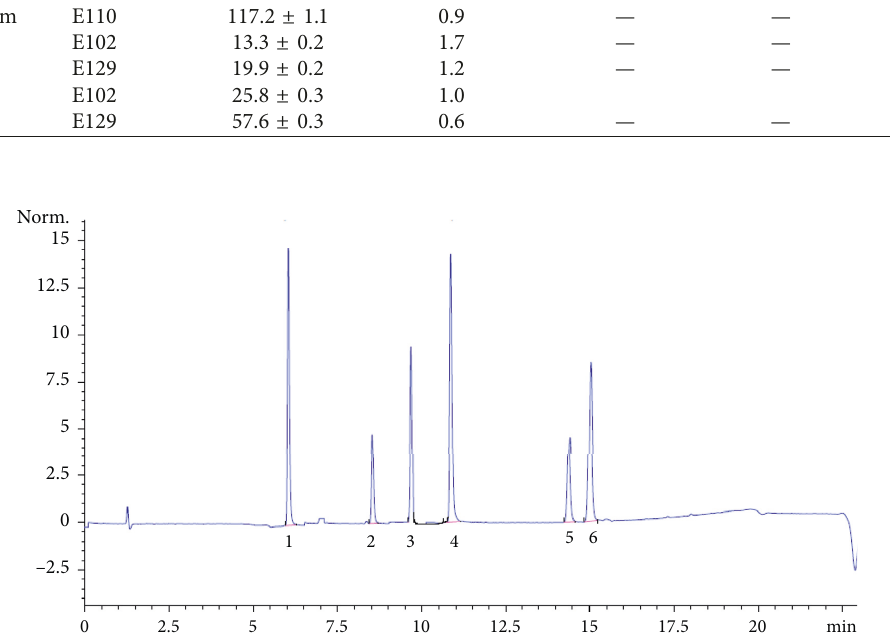
Figure 1: Chromatogram of a mixed standard dye solution by using the optimized gradient program in this study. Individual dye concentration was 1mg L − 1 .